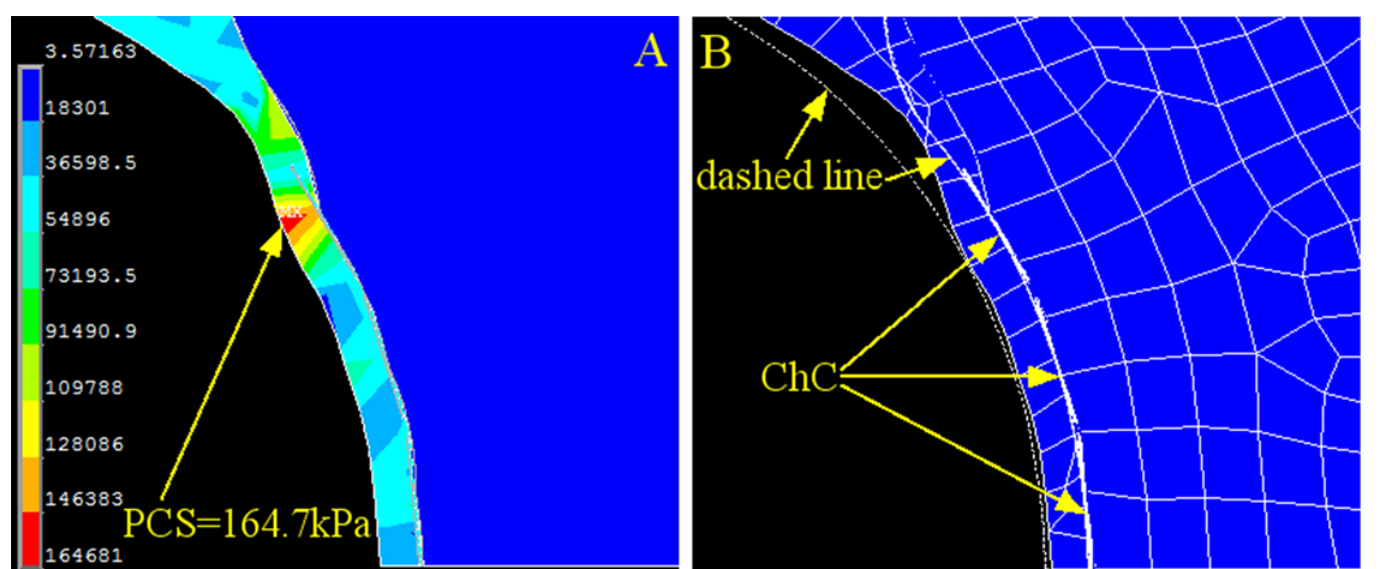
Fig 9. Stress and Strain of the Cap with Three Cholesterol Crystals at Three Positions. (A) Contour plot of the stress on the fibrous cap. (B) Corresponding strain contour of the fibrous cap in A. The dashed line is the original contour before loading (control case), and the meshed section is